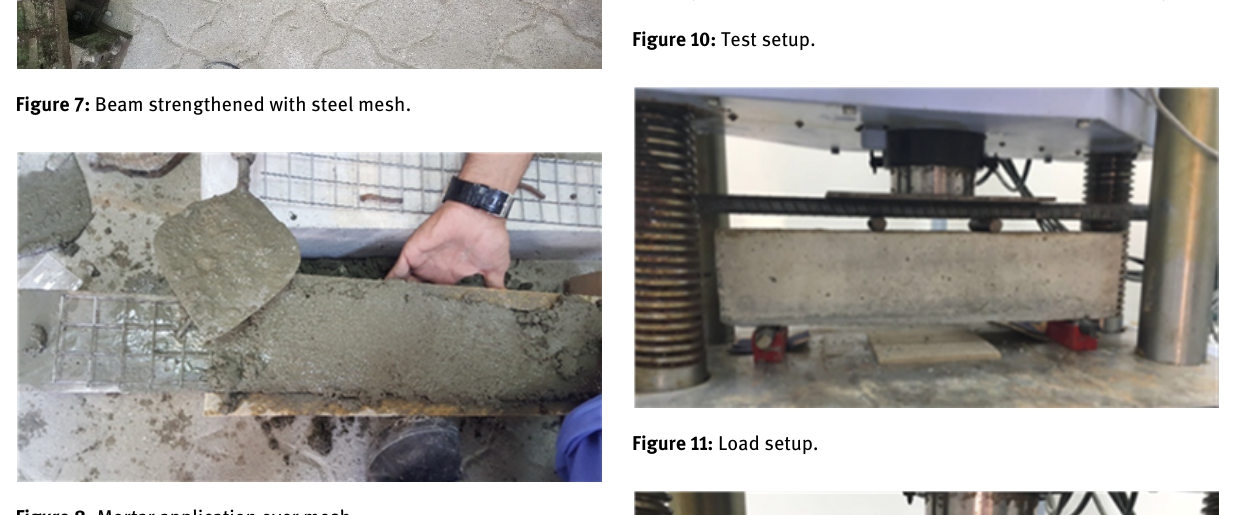
Figure 8: Mortar application over mesh.